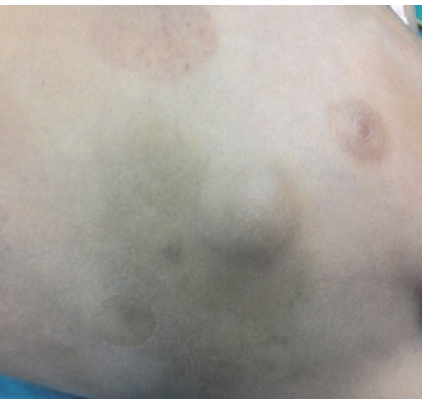
Figure 1: Presence of a palpable, spherical, painful, nut-sized subcutaneous lesion in the left lateral chest wall, respectively, with the anterior axillary line, at the height of the 6th to 7th intercostal space. Notice the ecchymosis on the overlying